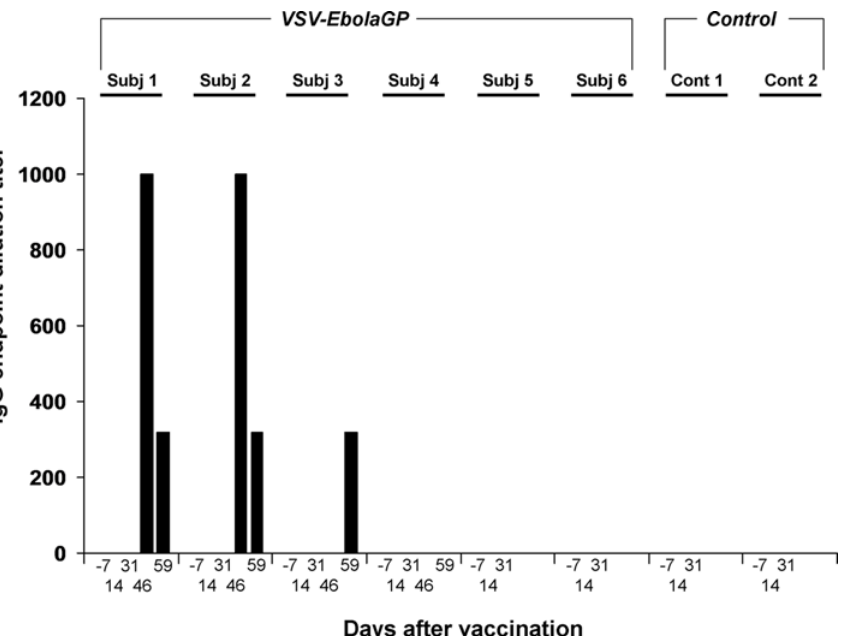
Figure 4. Circulating levels of IgG against ZEBOV from SHIV-infected rhesus macaques vaccinated with VSV D G/ZEBOVGP and challenged 31 days later with ZEBOV.